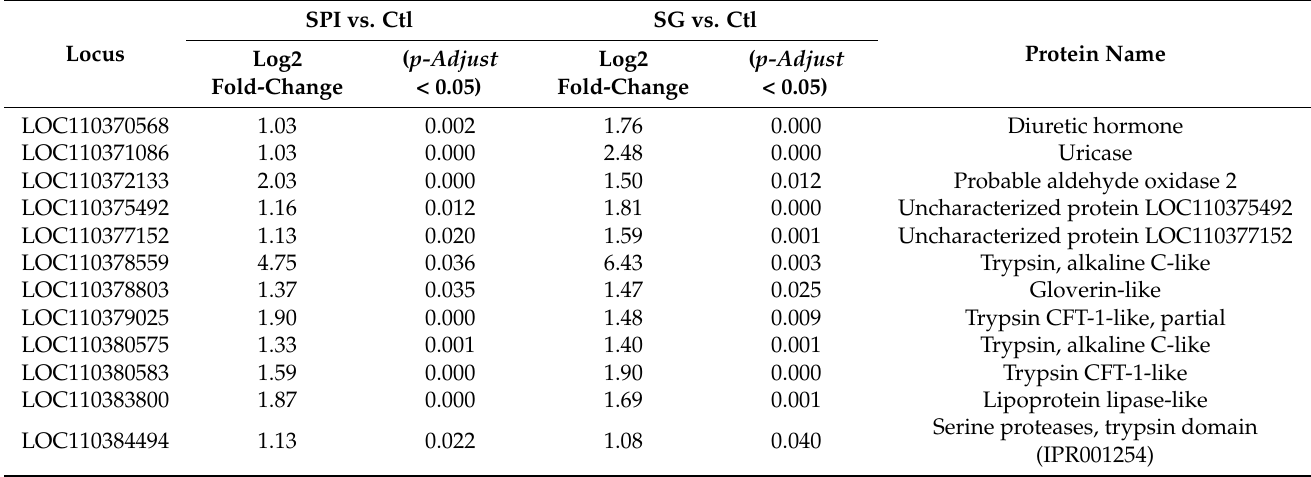
Table 1. Potential epialleles of upregulated genes induced by SPIs in H. armigera larvae.